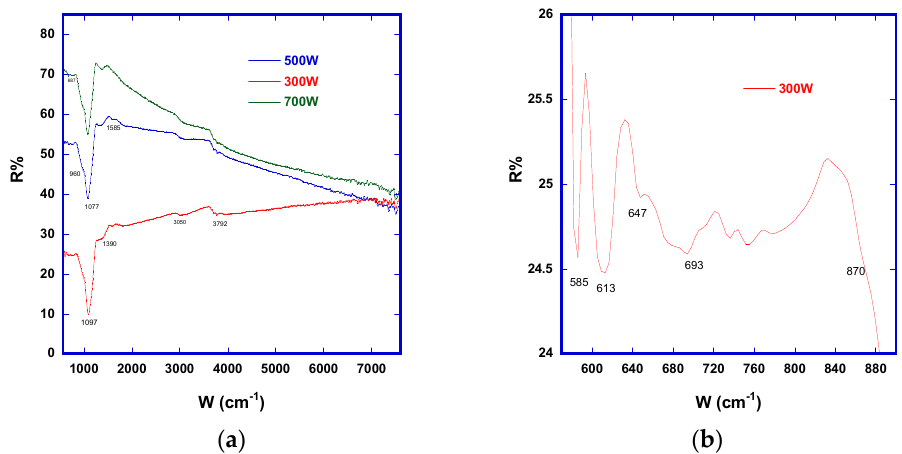
Figure 9. ( a ) FTIR Reflectance comparison; ( b ) 300 W FTIR inset with evidenced signals. Bands located at 647 cm − 1 and 693 cm − 1 , attributed to the bridging nitrogen W ‐ N ‐